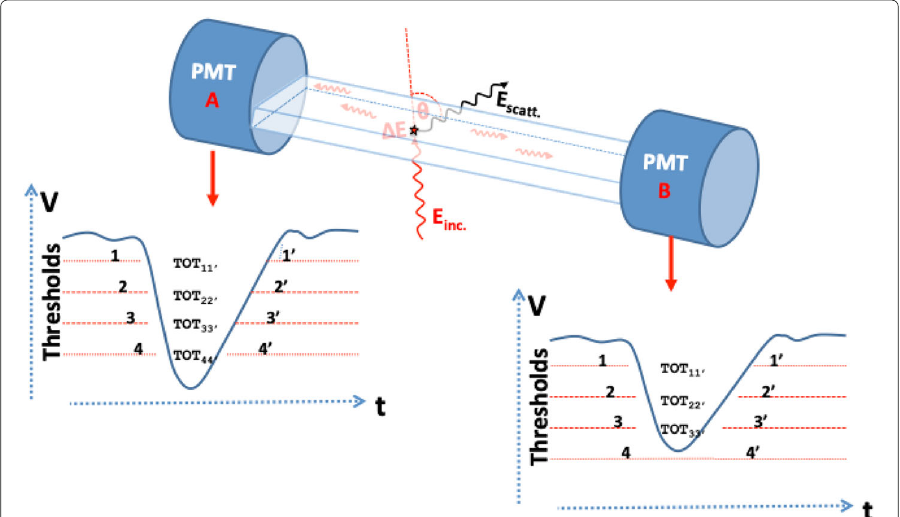
Fig. 2 Illustration of the analog signals obtained at photomultipliers as the outcome of the energy deposited by the photon in the interaction with plastic scintillator. Each signal is probed at four fixed thresholds. The TOT value is calculated at each pre-defined voltage threshold, and the sum of all four TOT values from both photomultipliers (PMTs) gives the final TOT value, Eq.